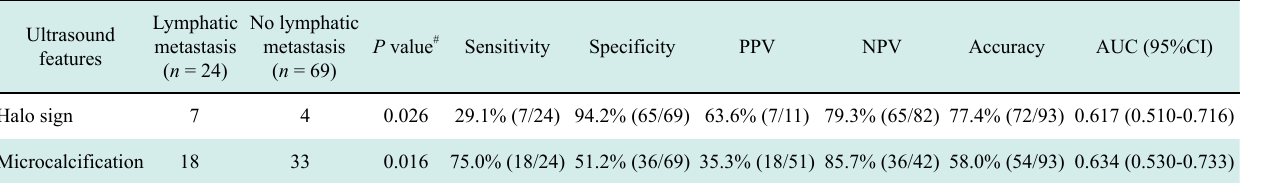
Table 5 Predictive value of conventional ultrasound in 93 malignant thyroid lesions Ultrasound